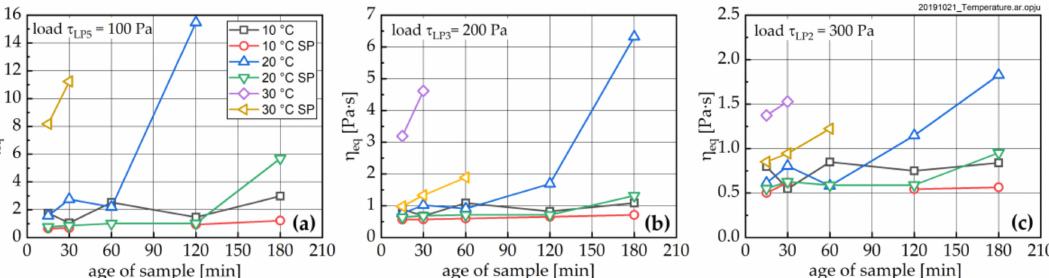
Figure 10. Change of equilibrium dynamic viscosity η eq as a function of time for di ff erent temperatures with and without SP addition for shear stresses of 100 Pa ( a ), 200 Pa ( b ) and 300 Pa ( c ), respectively. Mean standard deviation (SD); see Figure 9.